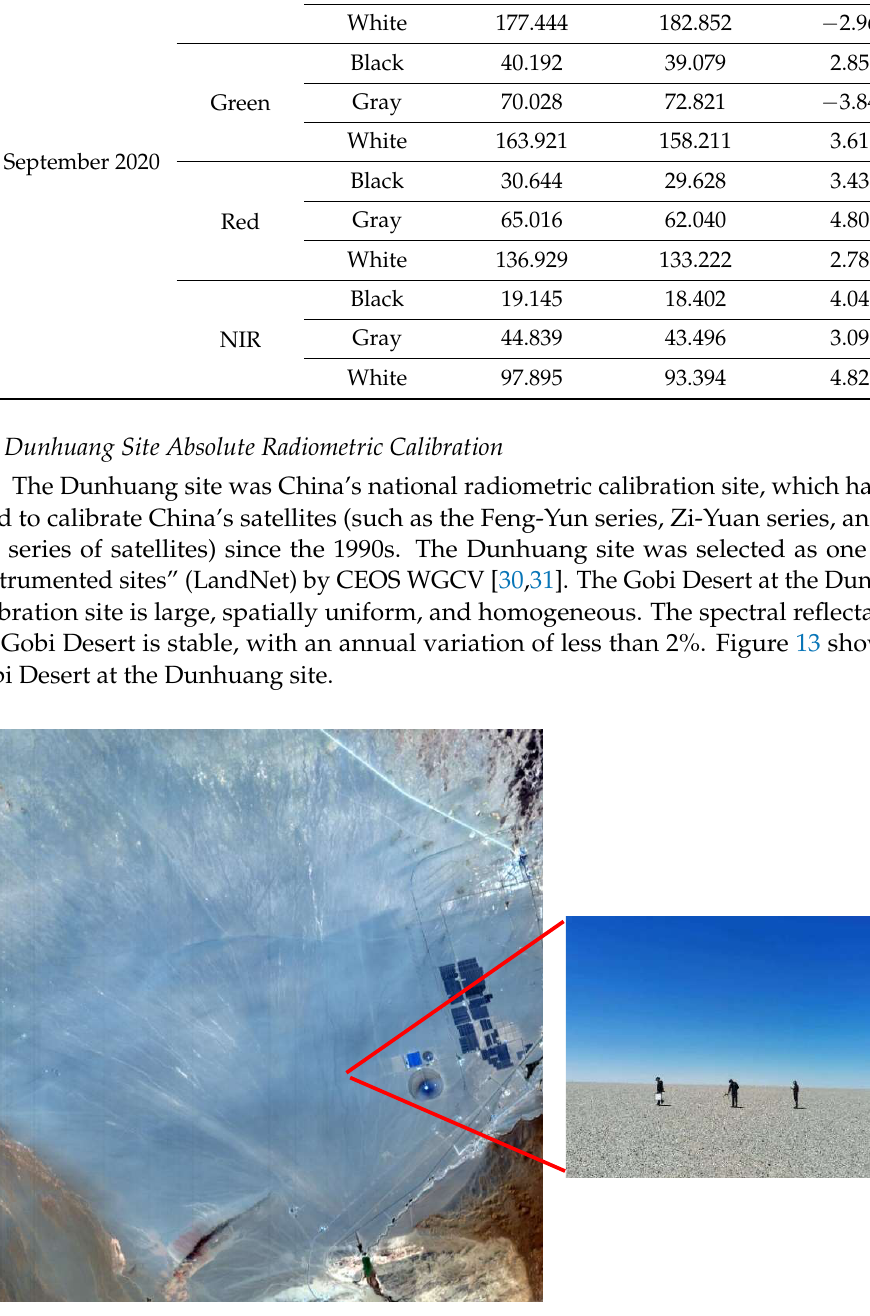
Figure 13. The Dunhuang calibration